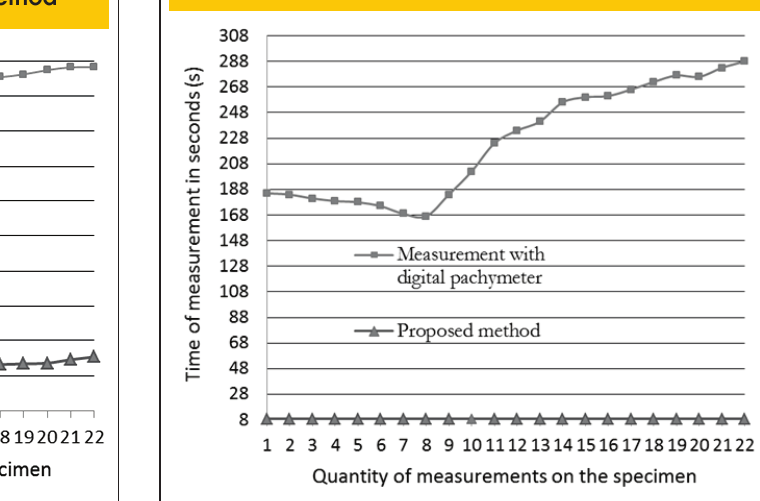
Figure 12 – Repeatability errors of crack measurements in the specimen. Total were performed 22 comparisons between the digital pachymeter and the proposed method